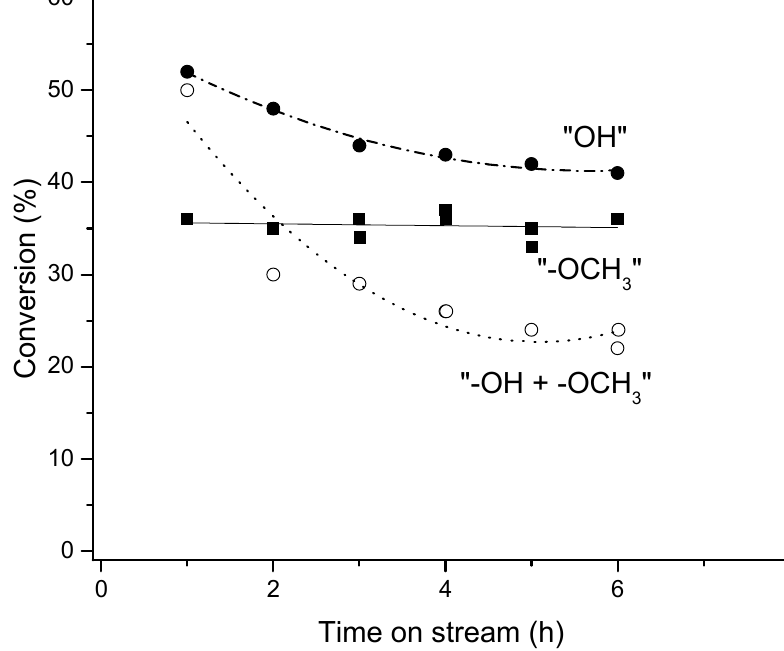
Figure 18. Conversion of guaiacol, anisole and phenol in their single feed HDO at 350 °C under 60 bar in a down flow trickle bed reactor adapted from [39]. Notation: ( ● ) phenol, ( ■ ) anisole and (o) guaiacol.